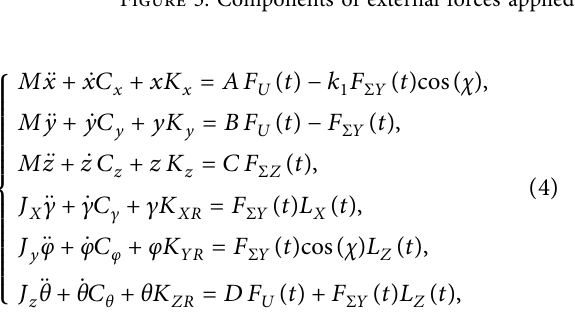
Figure 5: Components of external forces applied to the screen: deterministic (a) and stochastic